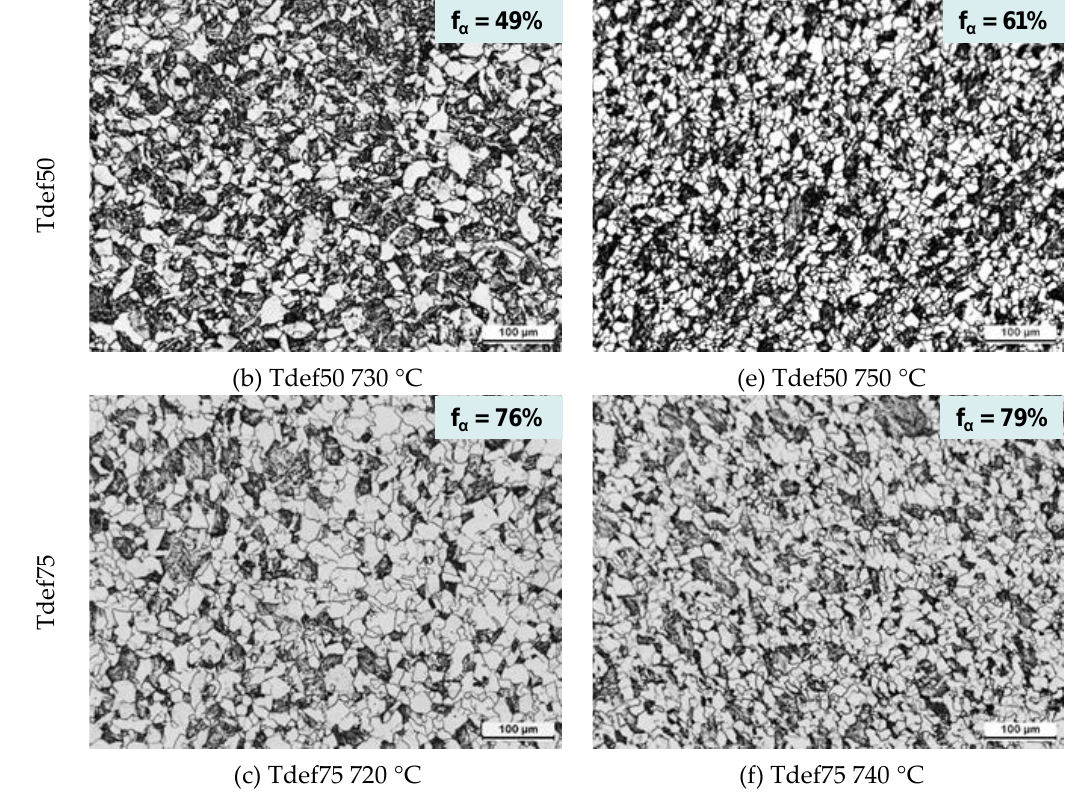
Figure 4. Optical micrographs obtained after a quenching at different deformation temperatures (before intercritical deformation) and both austenite conditions for NbV-microalloyed steel (recrystallized and deformed): ( a , d ) Tdef25, ( b , e ) Tdef50, and ( c , f ) Tdef75. Table 2. Measured ferrite fraction in each deformation temperature, both chemical compositions, and austenite conditions after